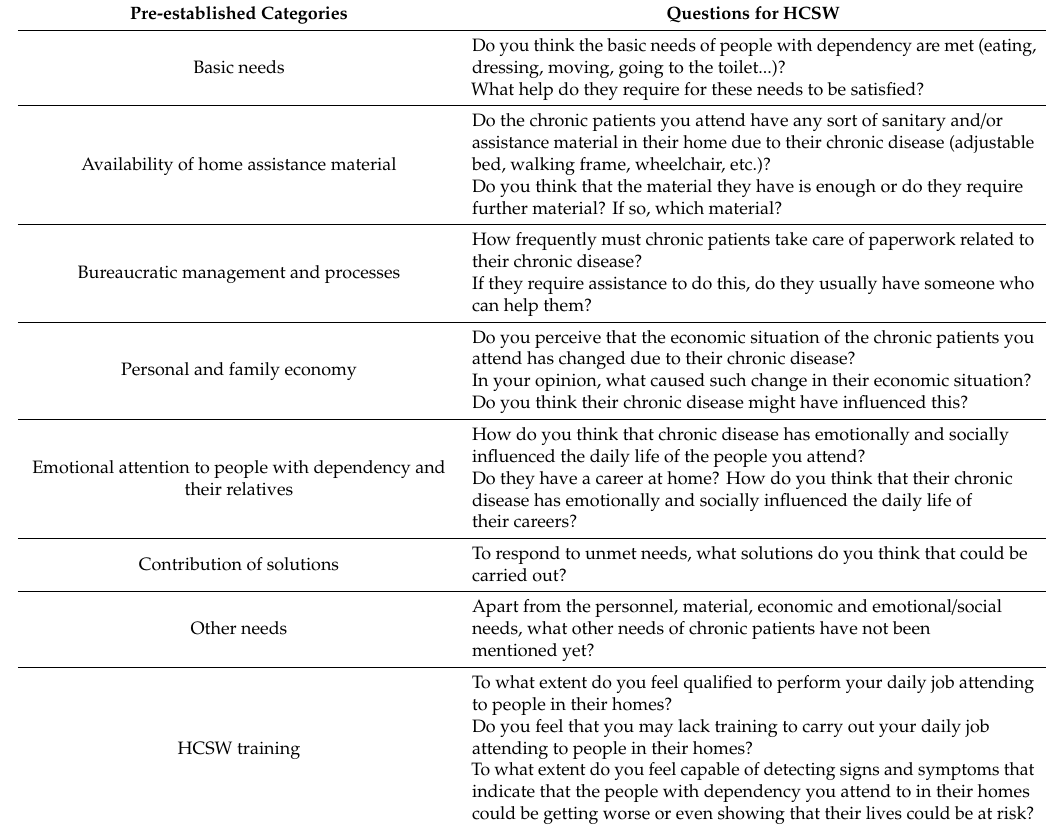
Table 3. Main questions asked in the focus